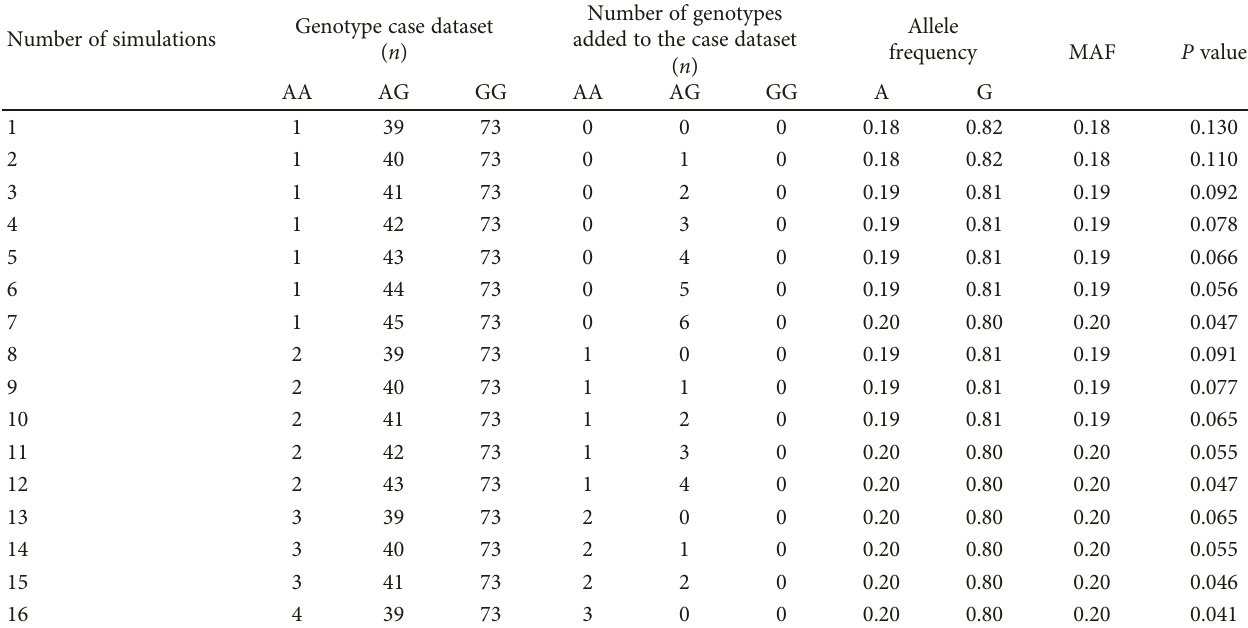
Table 1: Simulation of genotype distribution in a potential population